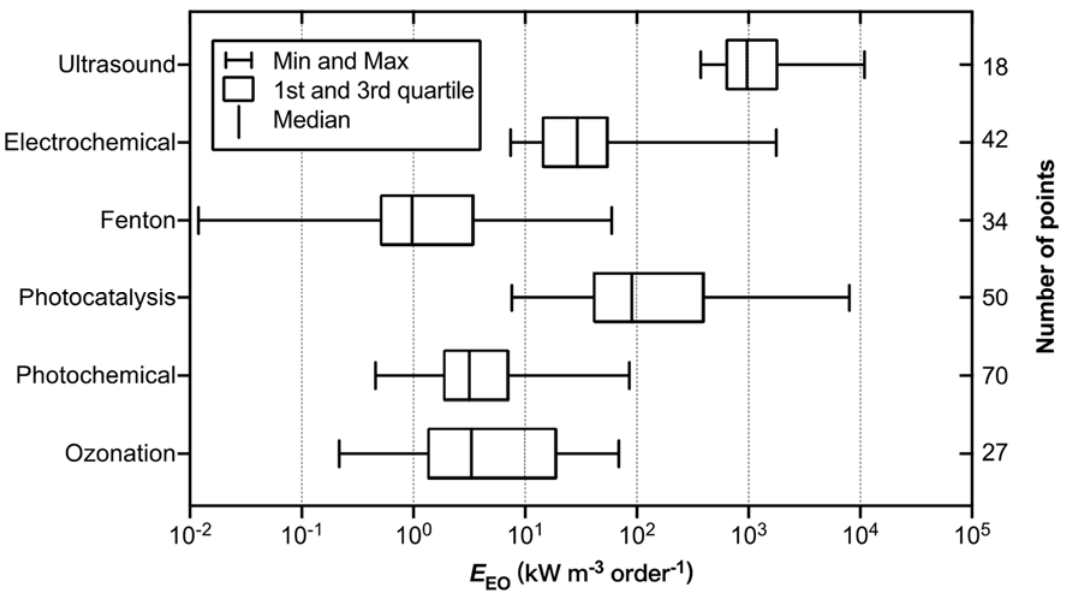
Figure 4. E EO values of various AOPs on textile wastewater treatment.